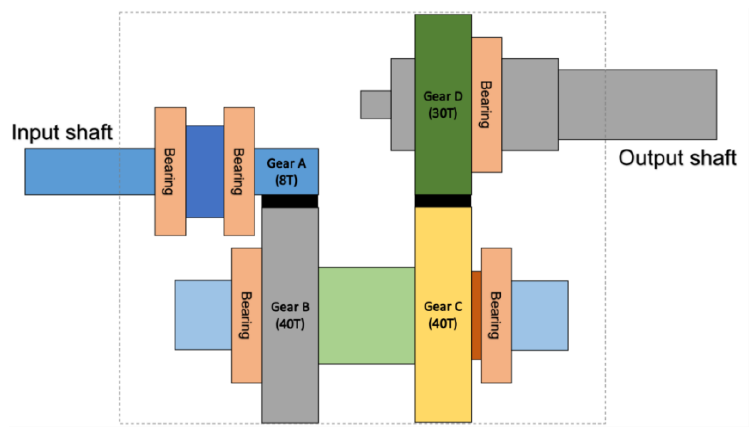
Figure 5. Gearbox structure.